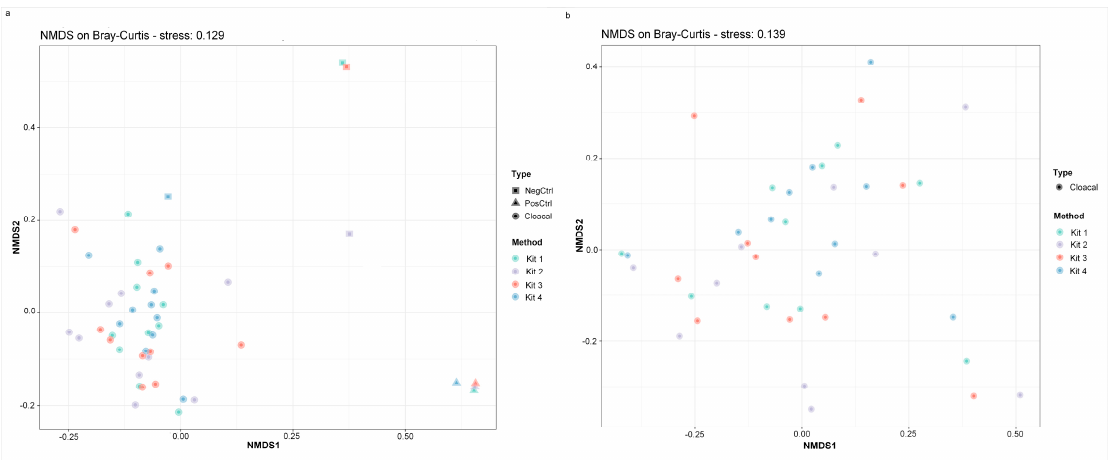
Figure 3. DNA extraction method does not affect bacterial community structure. Non-metric multidimensional scaling (NMDS) on Bray–Curtis distances with ( a ) and without ( b ) controls. The DNA extraction methods are shown with different colors and the type of sample (cloacal sample, negative control, or positive control) are shown with different shapes. Differences in community structure were not significant between DNA extraction methods ( p > 0.05, PERMANOVA).